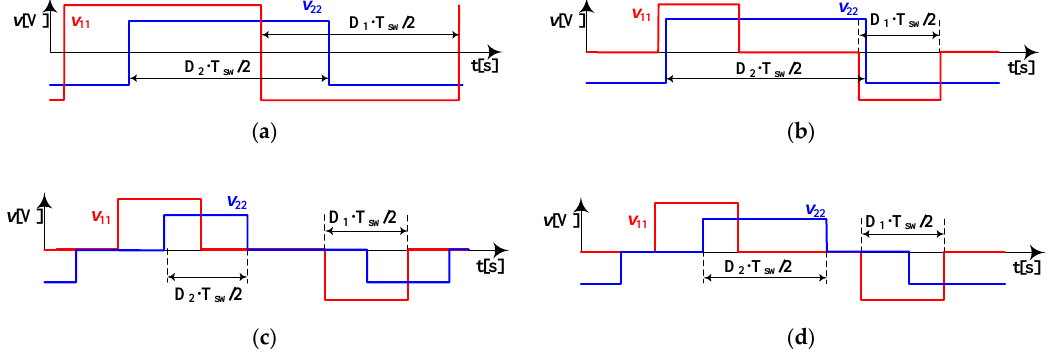
Figure 2. Types of modulation applied to Dual active bridge (DAB). ( a ) Phase shift (PS); ( b ) Extended phase shift (EPS); ( c ) Dual phase shift (DPS); and ( d ) Triple phase shift (TPS).